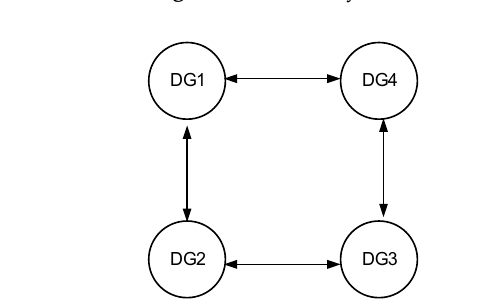
Figure 5. Communication network.